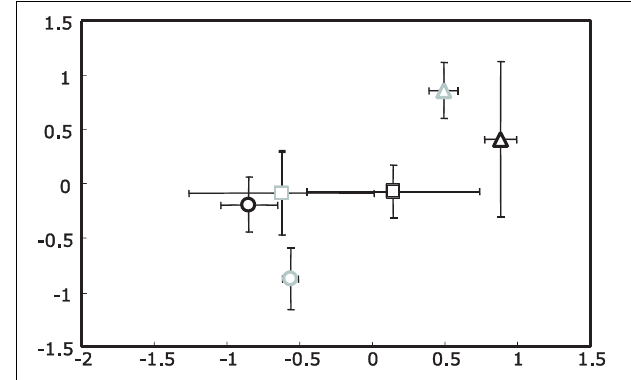
FIGURE 1 | Non-metric Multidimensional Scaling (NMS) plot of actinobacterial 16S rRNA gene T-RFLP profiles for rhizosphere DNA. Upright triangles indicate spring, circles summer and squares autumn samples. Ozone treated samples are shown in gray, while controls are black. Stress value was 4.48 given according to Kruskal’s stress formula 1 multiplied by